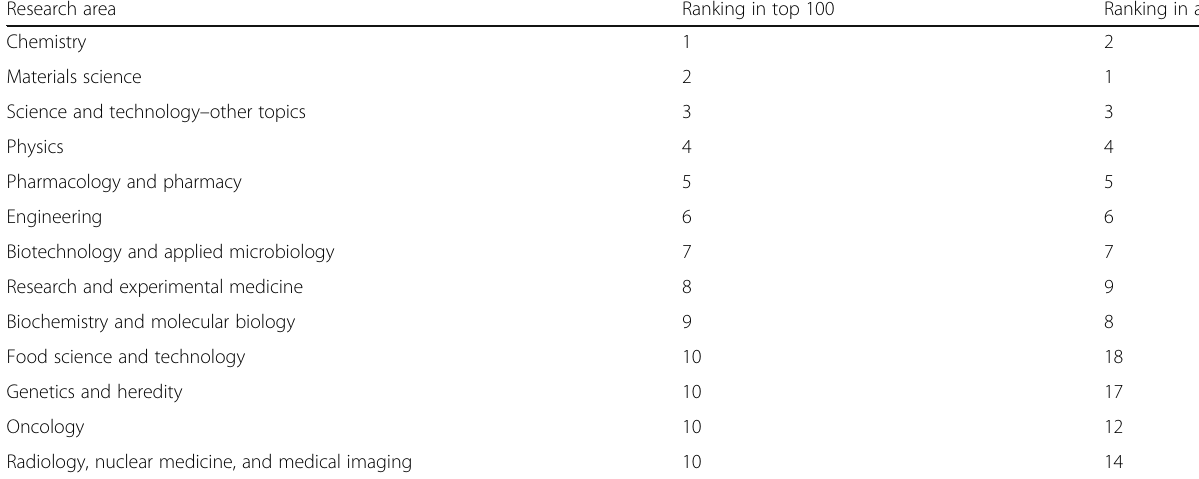
Table 4 Comparing research areas repeated times in the top 100 best cited papers with research areas in all papers Research area Ranking in top 100 Ranking in